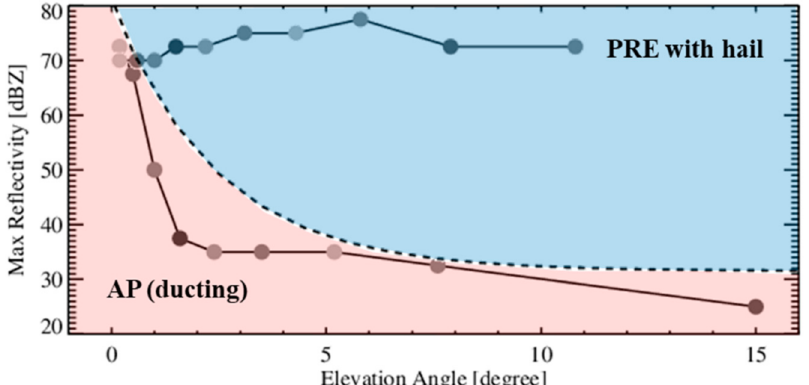
Figure 7. Observed maximum reflectivity with each elevation angle for a strong convective system and severe anomalous propagation case, The red shaded area indicates the reflectivity range with observational elevation angles for AP whereas the blue shaded area indicates the reflectivity range that can be excluded from NPE classification when the maximum reflectivity with observational elevation angles is applied as the dashed